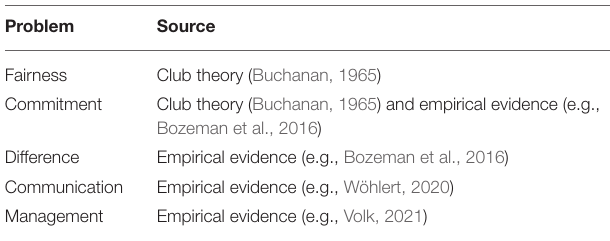
TABLE 1 | Problems in RCs as derived from theory and empirical